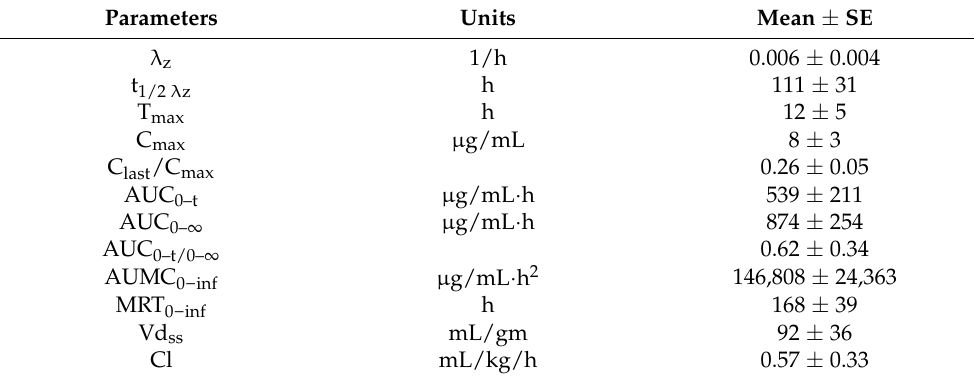
Table 1. Toxicokinetic parameters for amitraz calculated from the mean blood concentration after a single dermal application to Malabari goats. Parameters Units Mean ± SE λ z 1/h 0.006 ± 0.004 t 1/2 λ z h 111 ± 31 T